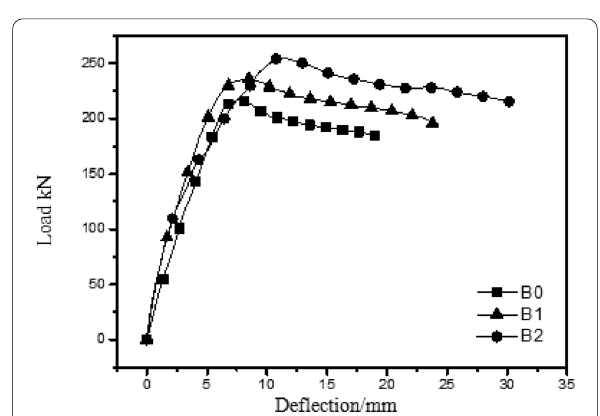
Fig. 7 Load–midspan deflection curve of test